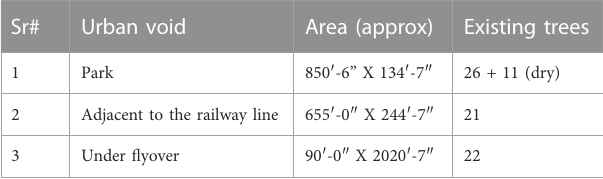
TABLE 3 Existing site area and